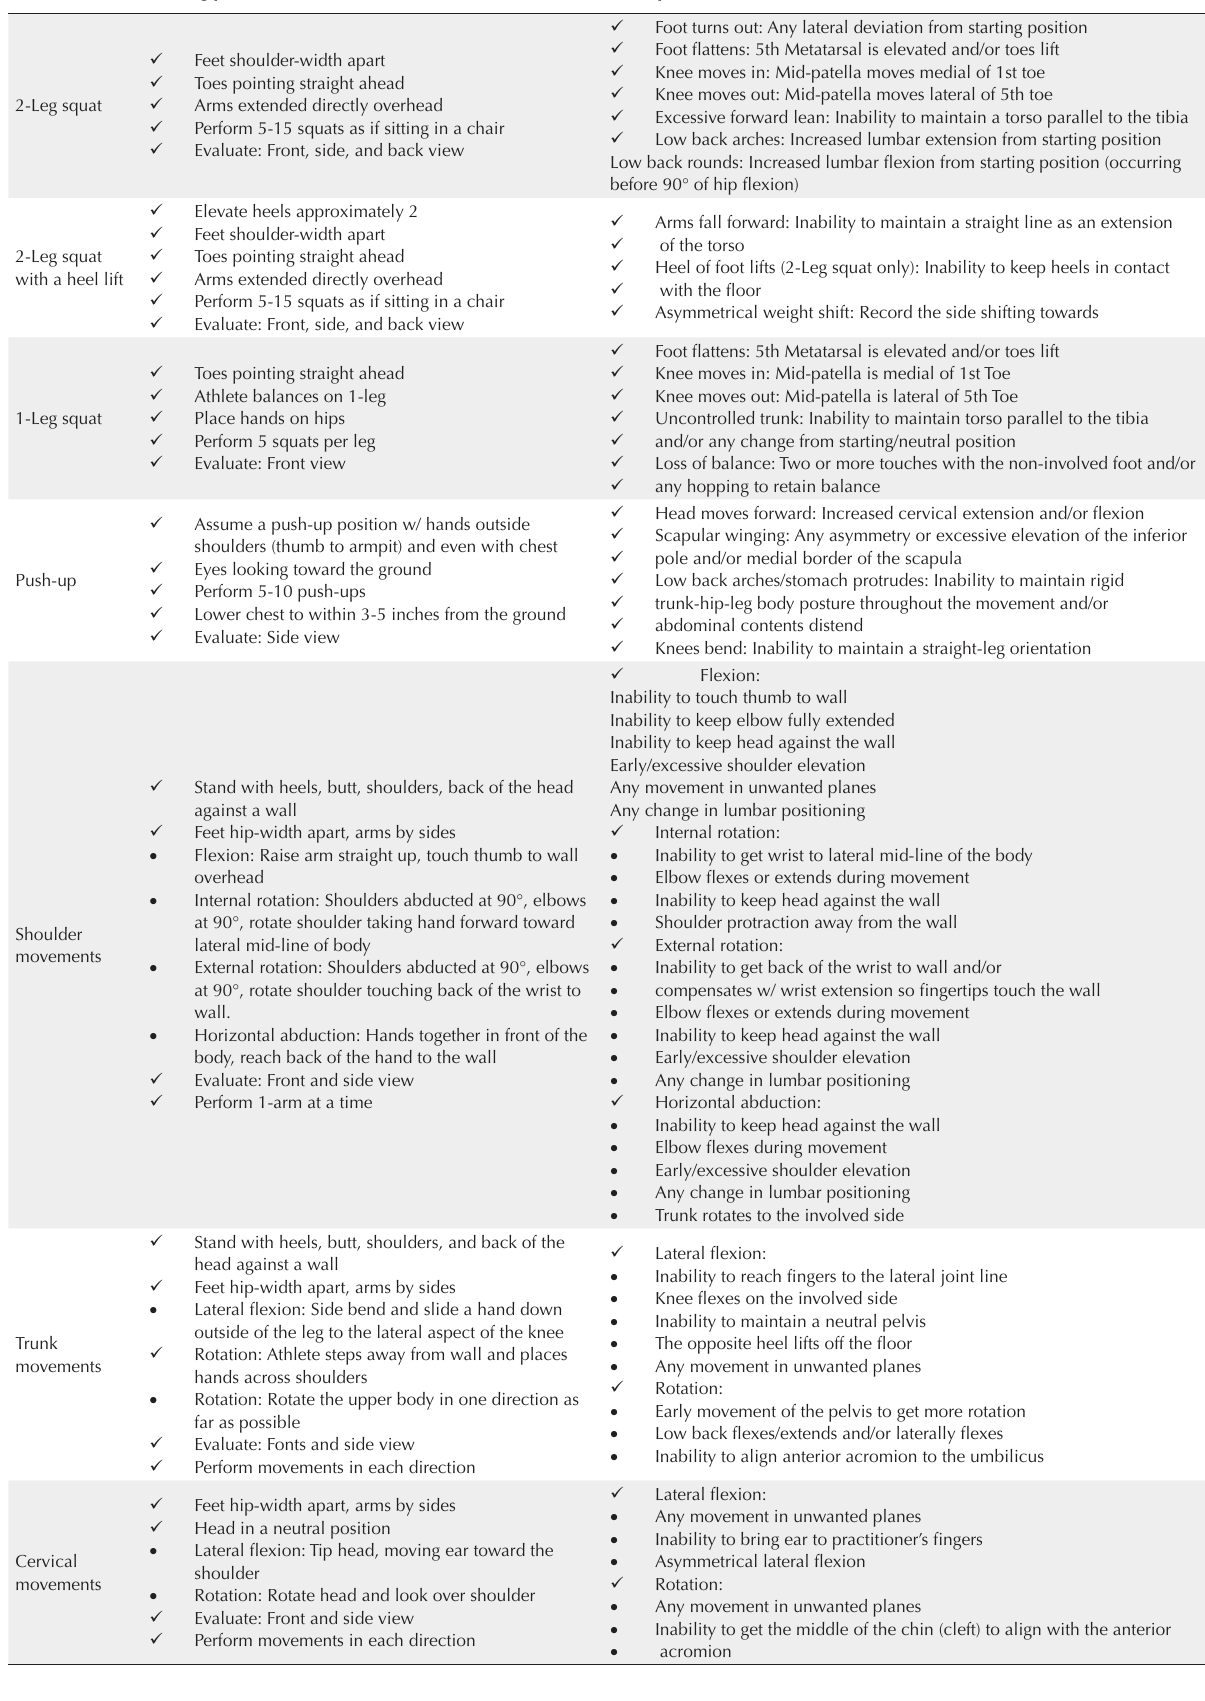
Table 1. Movement efficiency test checklist Test/Movement Starting position/movement instructions Checkpoint evaluation/observation criteria for